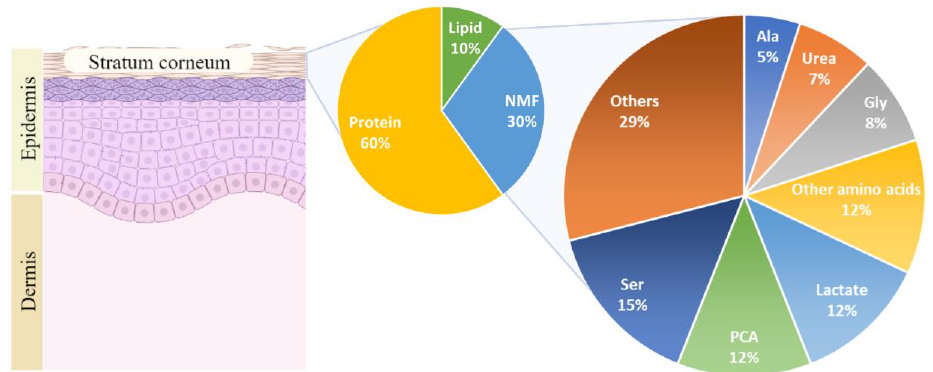
Figure 1. Composition of skin and natural moisturising factor. NMF natural moisturising factor Ala — alanine, Gly — glycine, Ser — Serine, PCA pyrrolidone carboxylic acid.